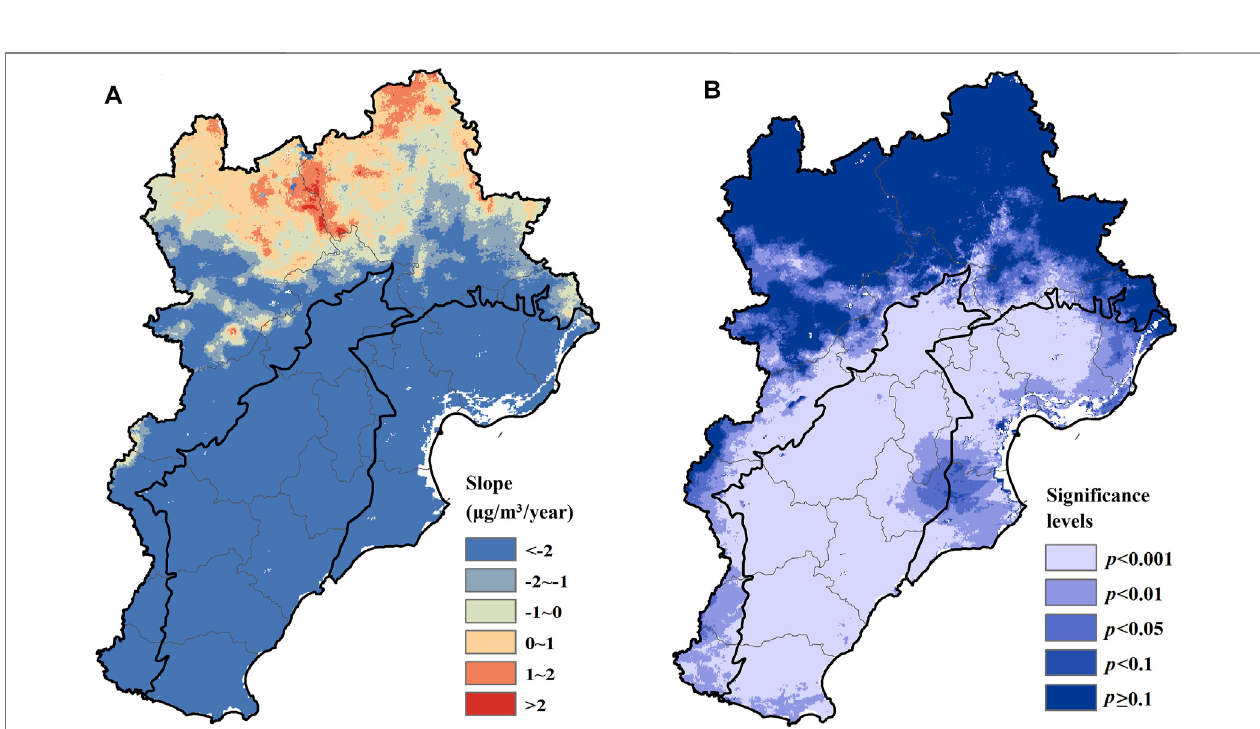
FIGURE 6 | Spatial distributions of the slope (A) and signi fi cance levels (B) of annual mean PM 2.5 concentrations in the Beijing – Tianjin – Hebei region from 2013 to 2020.